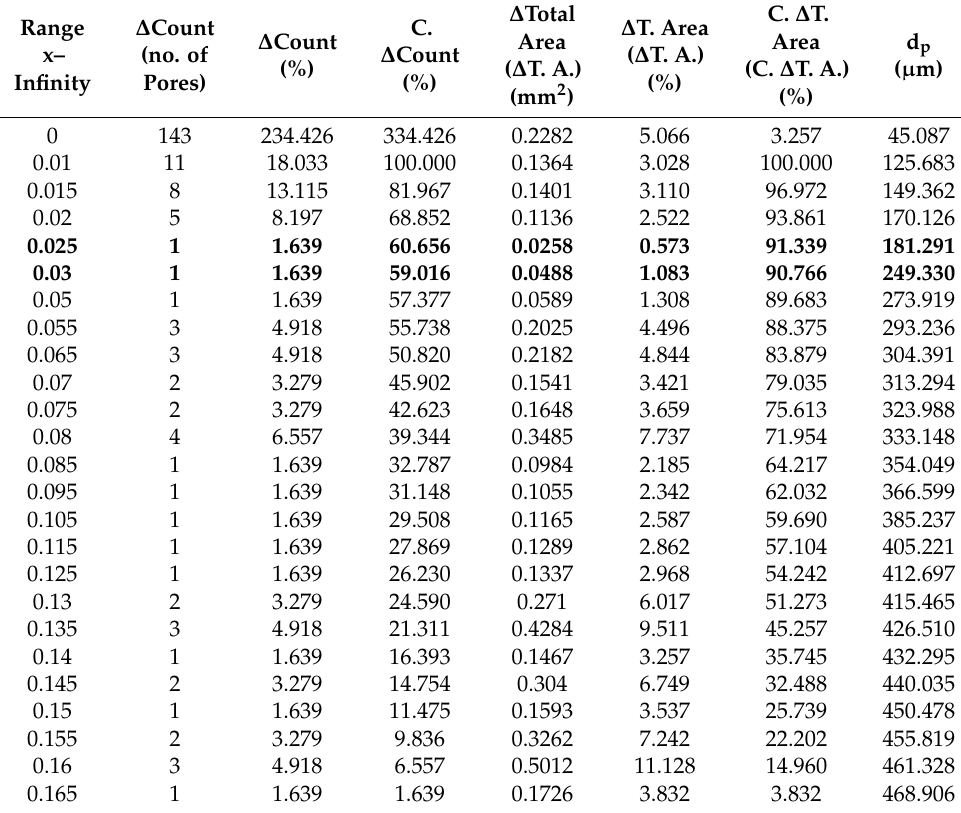
Table A1. Calculation of porosity parameters based on measurements in Table